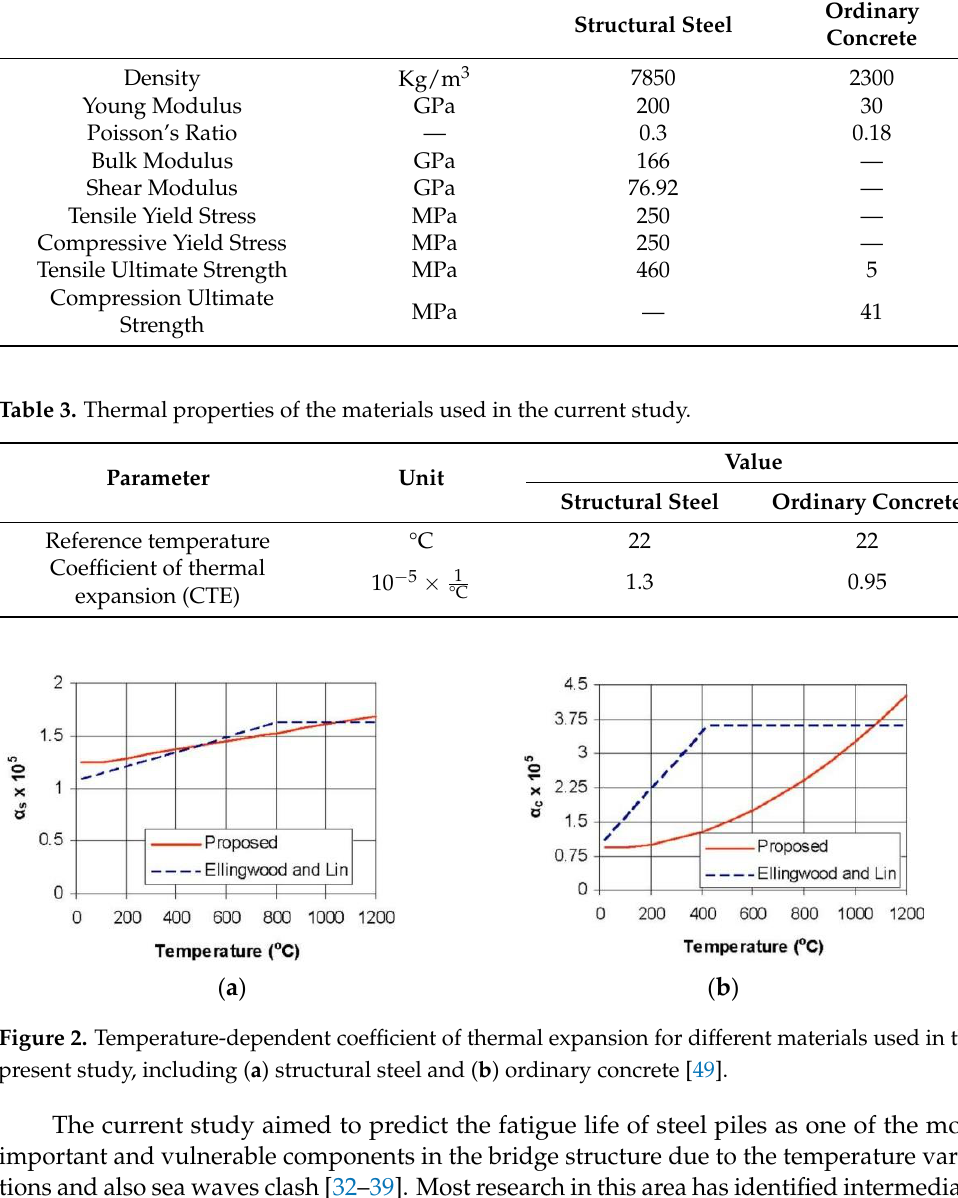
Table 2. Mechanical characteristics of the materials used in the current study [37,39].